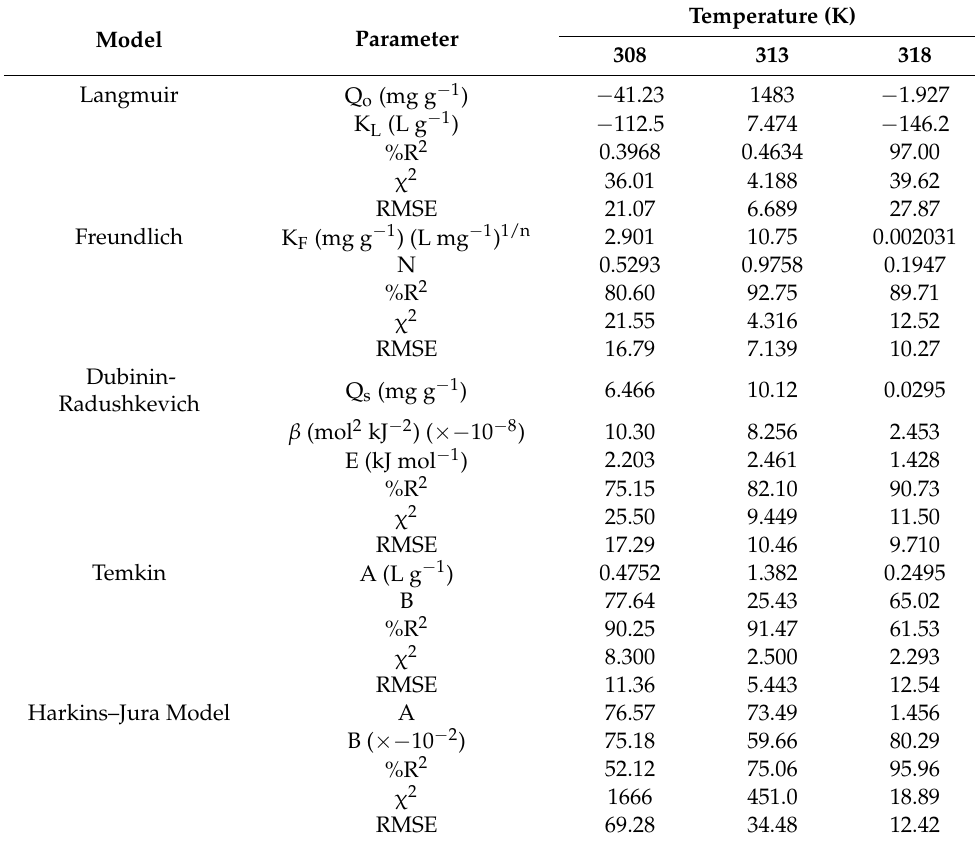
Table 4. Analysis of the adsorption of CV dye on the IZNC by various isotherm